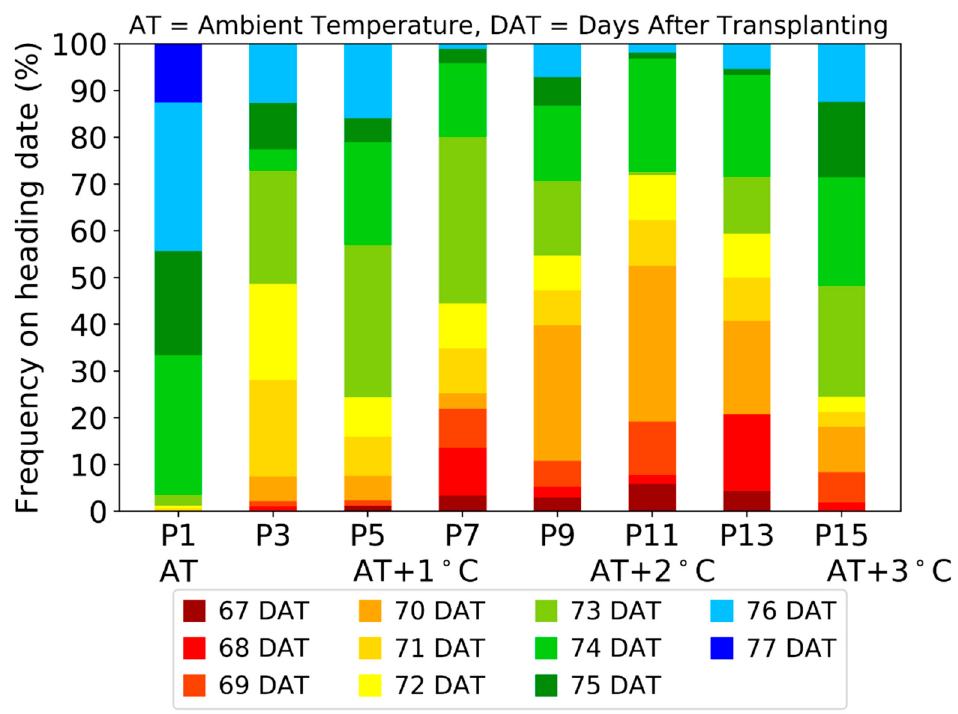
Figure 4. Different heading dates of paddy rice depending on air temperature. The survey positions were expressed as P1 to P15. P1 indicates a position at ambient temperature (AT) and P15 indicates a position at near AT+3 °C.